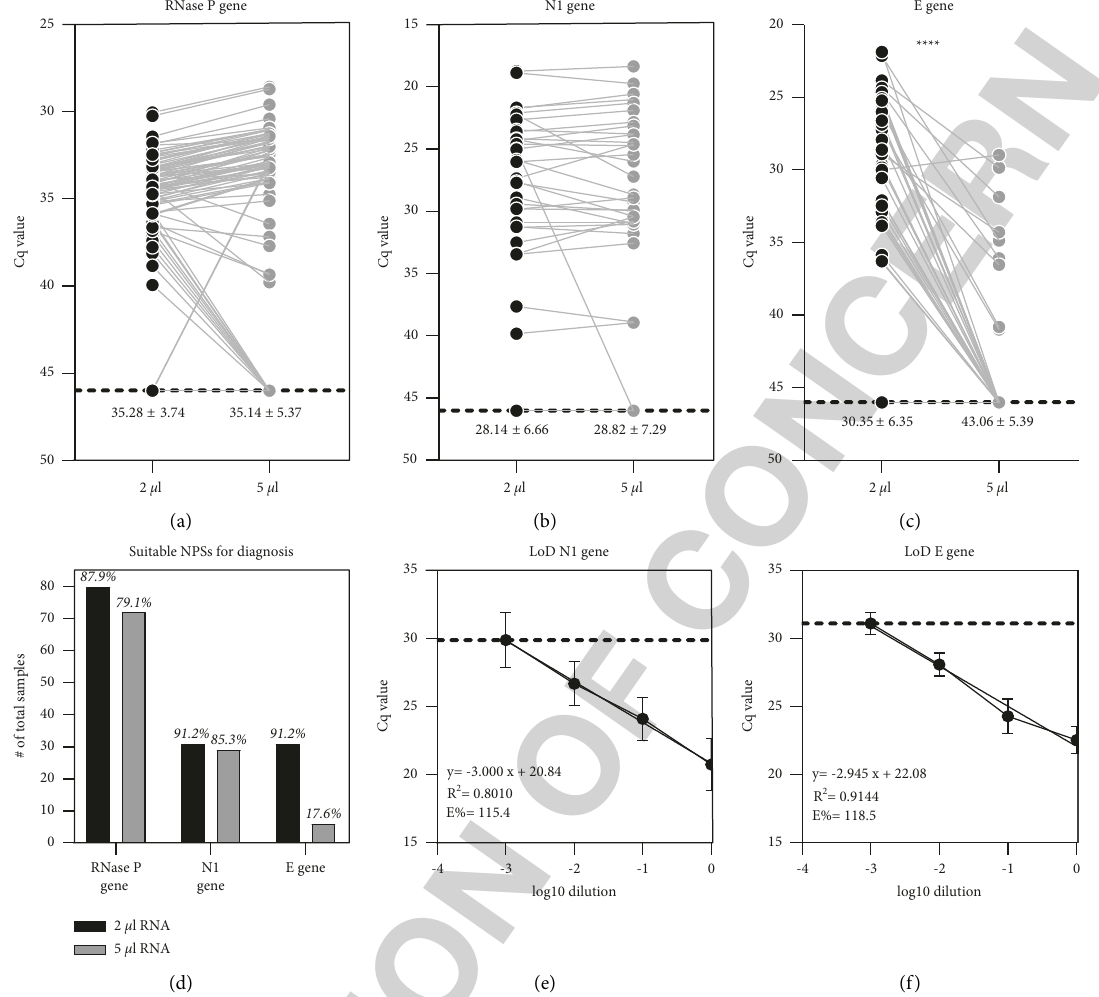
Figure 1: Determination of total RNA extracted from nasopharyngeal swab samples (NPSs) loading volume and the limit of detection (LoD) of SARS-CoV-2 probes using TAAG RT-qPCR kit. The upper section of the figure represents the Cq value paired comparison for total RNA extracted from NPSs loading volume determination. The analysis was made from the same NPSs using the manu- facturer’s recommended volume of 5 μ l and 2 μ l of total RNA extracted. In the graphs, the comparison was made for (a) RNase P internal reference, (b) N1, and (c) E viral gene probes. Each spot is a different analyzed sample for each volume condition (2 μ l; 5 μ l). On (a-c), the mean ± standard deviation (mean ± SD) for all the samples evaluated is indicated for each total RNA volume condition (2 μ l; 5 μ l). The line linking the spots indicate the paired result obtained for the same sample assessed using the two different volume conditions. Samples with Cq � 46 denote no amplification (indicated in the graph by a black broken line). For statistical analysis, paired two-sided student’ t -test was applied ( n � 80 random NPSs, n � 31 N1 gene, and n � 31 E gene random positive SARS-CoV-2 NPSs, ∗∗∗∗ p < 0 . 05). The lower section of the figure represents (d) the number of amplified samples using TAAG probes loading 2 and 5 μ l of total RNA extracted. Limit of detection (LoD) for (e) N1 gene probe and (f) E gene probe for SARS-CoV-2 detection. The analysis included 10-fold serial dilutions from a reference pool made from randomized ten total RNA NPS-extracted samples with a Cq value close to 20 (previously obtained using the Thermo Fisher kit). For the LoD determination, a linear regression was performed.